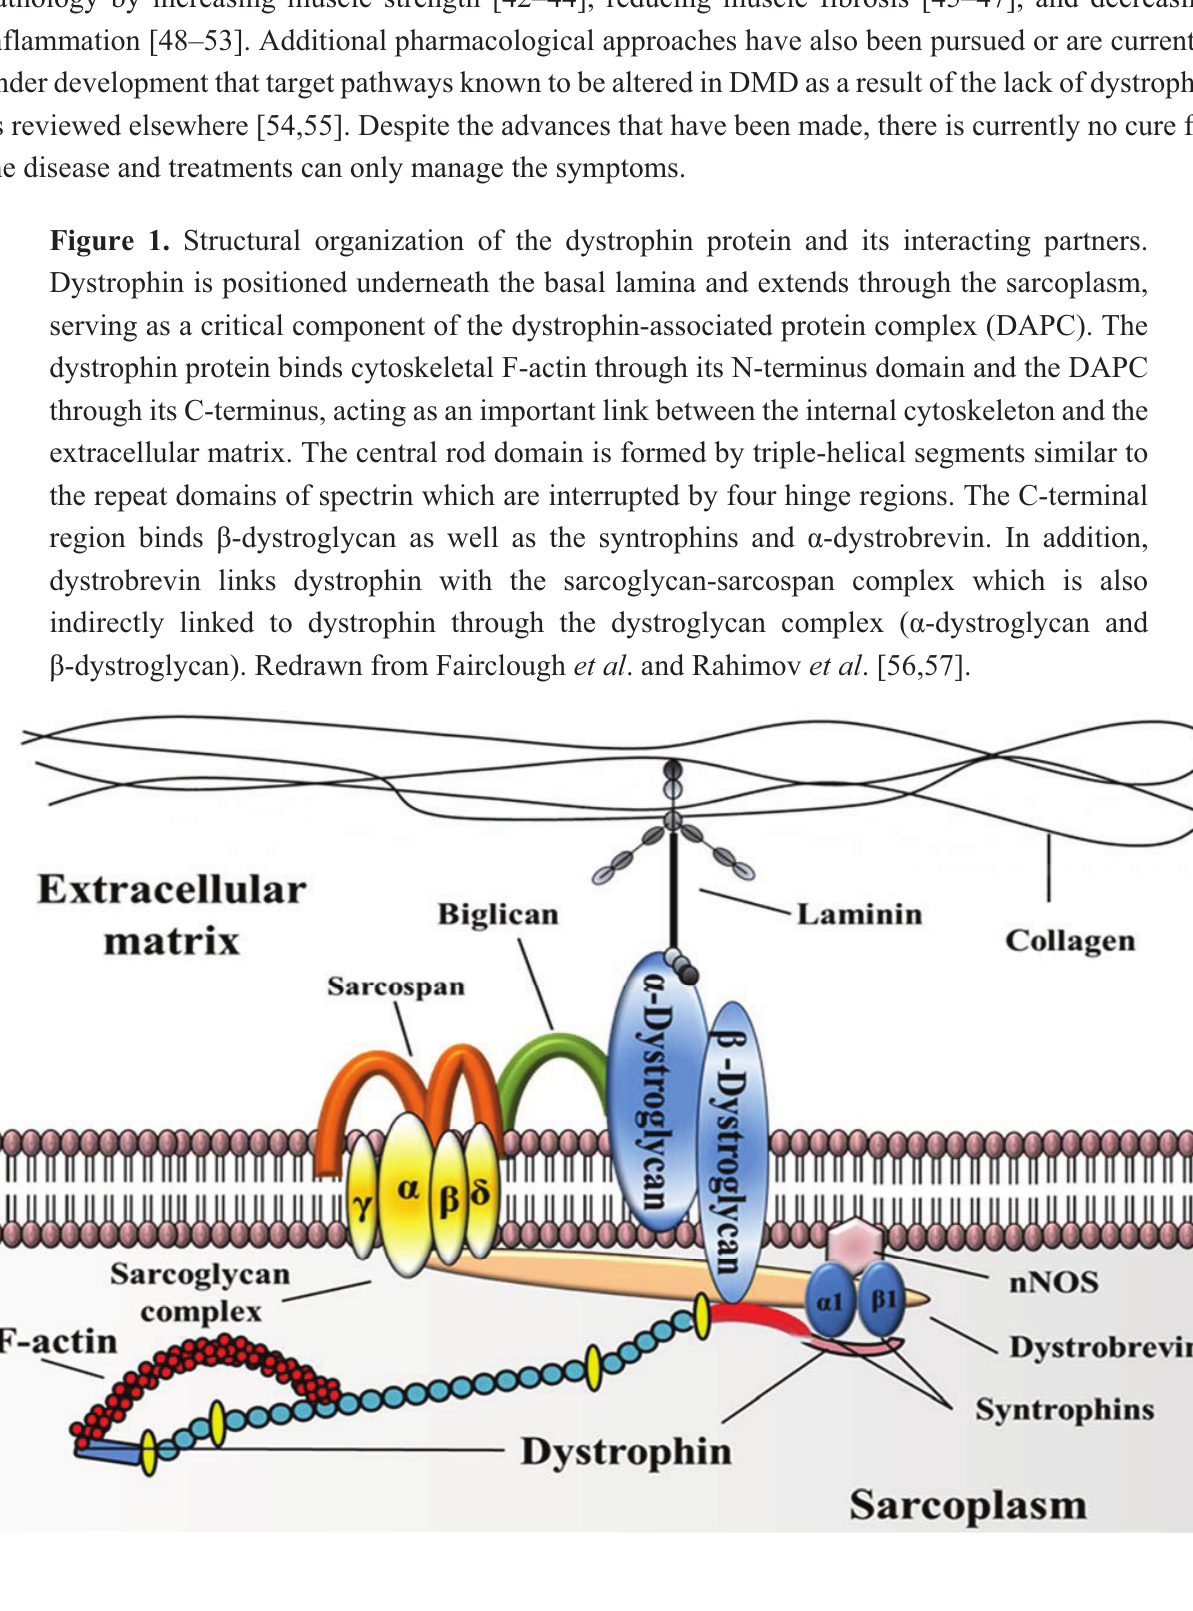
Figure 1. Structural organization of the dystrophin protein and its interacting